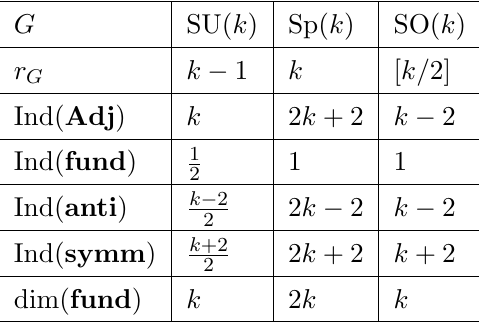
Table 1 . Relevant group theory